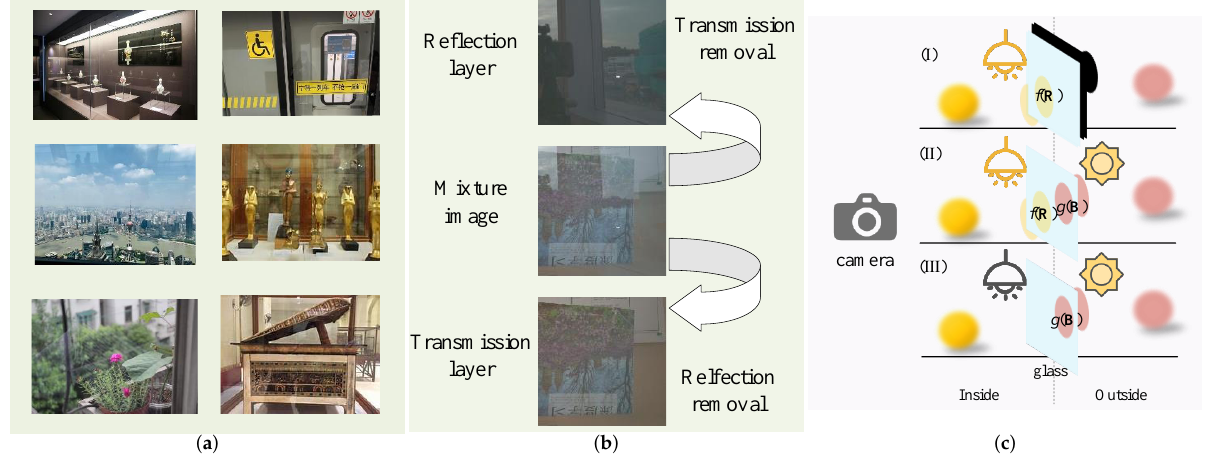
Figure 1. Image shooting principle under an ambient light environment. ( a ) Real-world glass scenes with reflections; ( b ) imaging principles; ( c ) reflection removal versus transmission